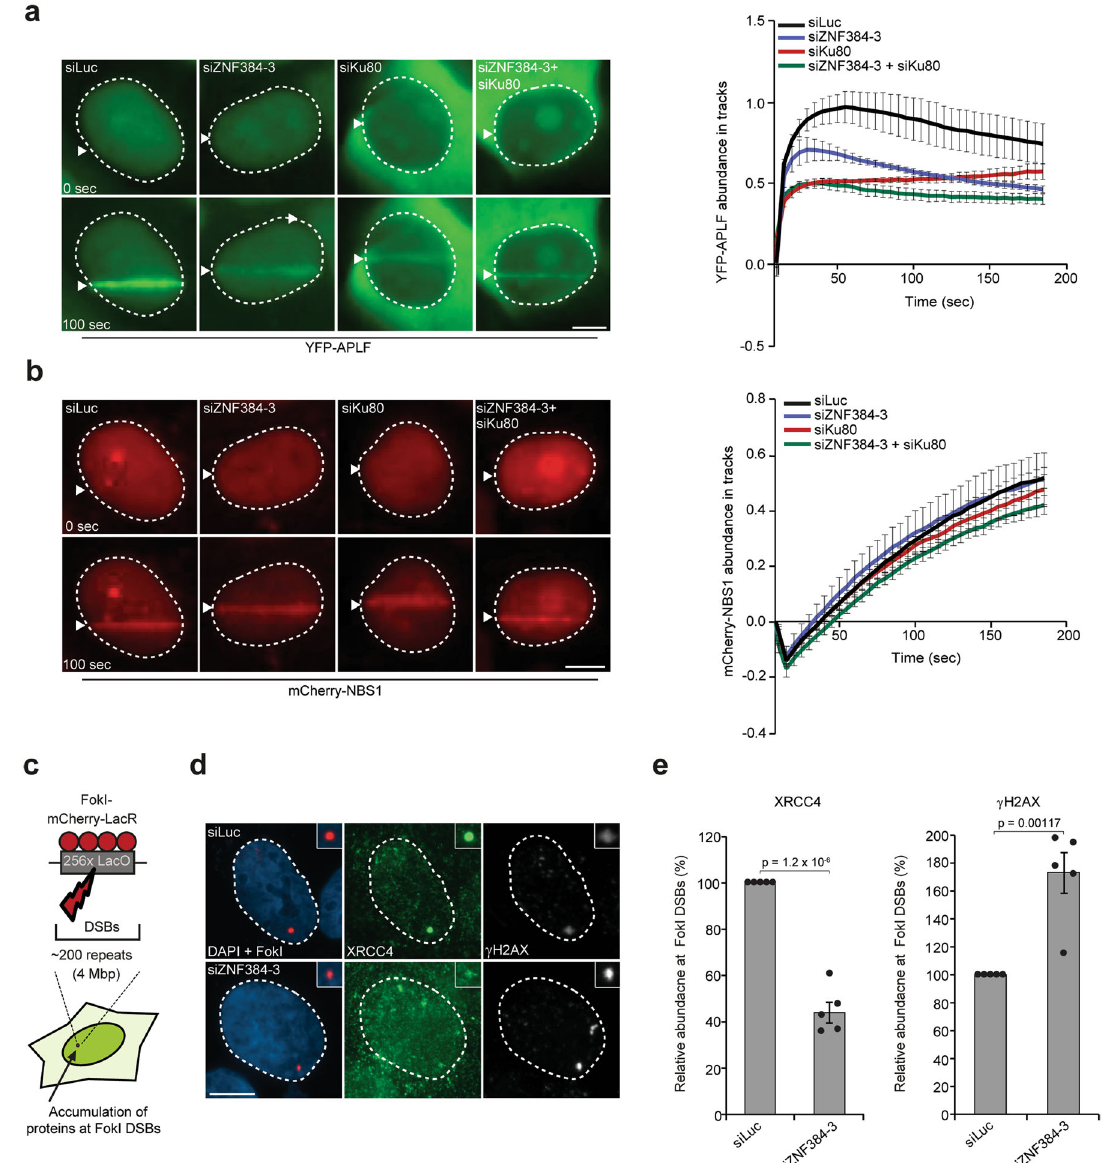
Fig. 6 ZNF384 promotes Ku-dependent loading of APLF and XRCC4/LIG4 at DSBs. a Live-cell imaging of the recruitment of YFP-APLF to 365 nm UV-A tracks in BrdU-sensitized U2OS cells transfected with the indicated siRNAs. mCherry-NBS1, which was co-expressed with YFP-APLF, served as a DNA damage marker. Representative images are shown. White triangles indicate irradiated regions (left panel). Quanti fi cation of data is presented as the mean values ±SEM from 60 cells acquired in three independent experiments (right panel). b As in ( a ), except for mCherry-NBS1 (left panel). Quanti fi cation of data is presented as the mean values ± SEM from 60 cells acquired in three independent experiments (right panel). c Schematic of the system in U2OS 2- 6-3 cells used to locally induce multiple DSBs upon tethering of the FokI endonuclease. d Accumulation of XRCC4 (green) to γ H2AX-marked (white) DSBs induced by FokI-mCherry-LacR at a LacO array (red) in cells transfected with the indicated siRNAs. e Quanti fi cation of XRCC4 and γ H2AX in cells from ( d ) is presented as the mean ± SEM of >200 cells acquired in fi ve independent experiments. Data were normalized to siLuc control which was set to 100%. Statistical signi fi cance was calculated using the two-tailed unpaired Student ’ s t test, assuming unequal variances. Scale bar 5 μ m. Source data are provided as a Source Data fi